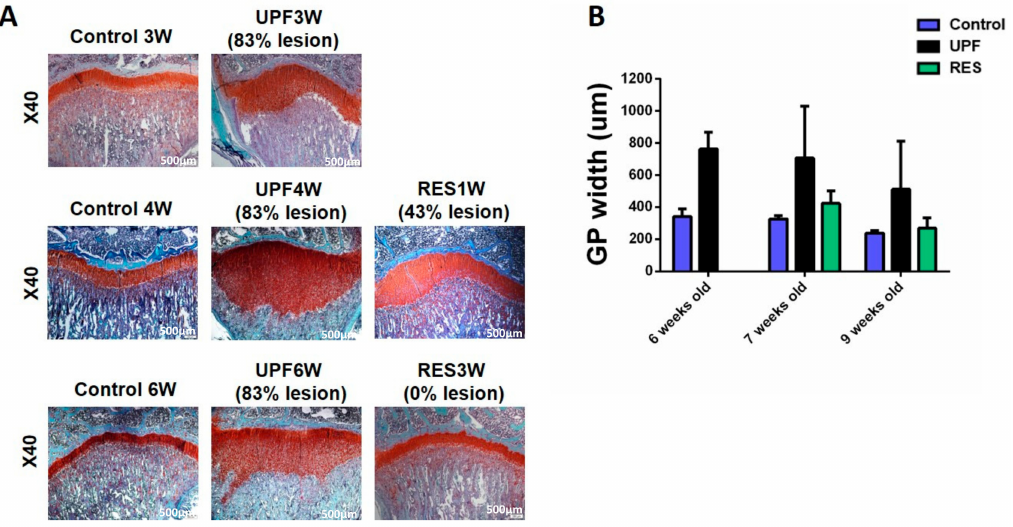
Figure 9. Short or prolonged transition to a balanced nutrition recovers the damage to the GP following UPF. ( A ) Tibiae from Control, UPF, and RES groups were dissected, processed, embedded in paraffin blocks, and stained with safranin-O. ( B ) The width of the whole GP was measured at ten different points along the GP, averaged for each GP, and then averaged with measurements from other GP samples in each